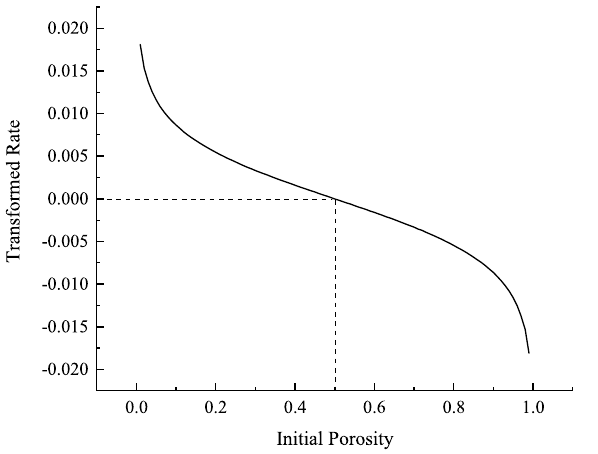
Figure 1. Transformation rate over initial porosity (in the case that d σ 1 = 0.5 Mpa/s, φ = 49.96 ◦ , c = 17.19 Mpa and σ 2 = 5